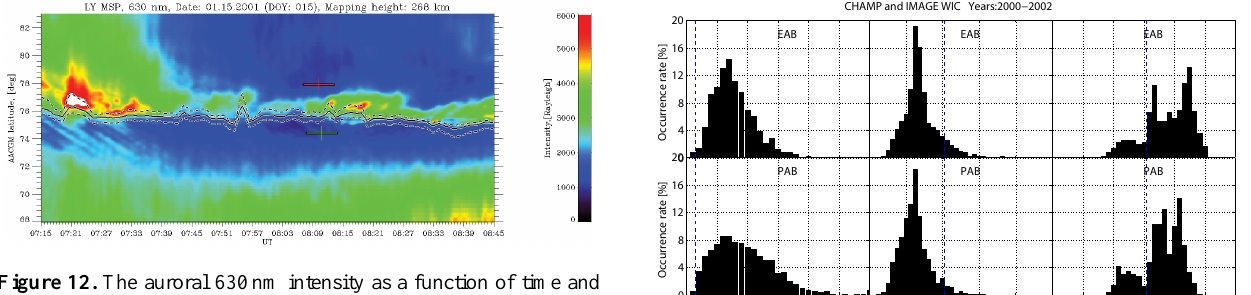
Figure 12. The auroral 630nm intensity as a function of time and Mlat as measured by the MSP on 15 January 2001. The equatorward and poleward oval boundaries derived from CHAMP FAC observa- tion are marked with green and crosses, respectively. Figure 13. The distribution of occurrence rates for good common